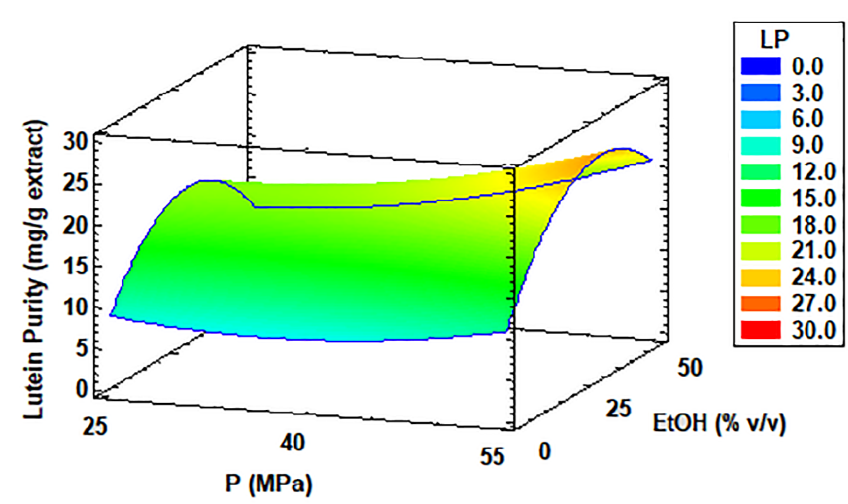
Figure 4. Response surface curve of the combined effects of temperature (30–70 °C), pressure (25–55 MPa), and ethanol as co-solvent (0–50% v / v ) on lutein purity (LP) from Coccomyxa onubensis. Response surface curves were drawn from the viewpoint of the optimal temperature (70 °C). Abbre-